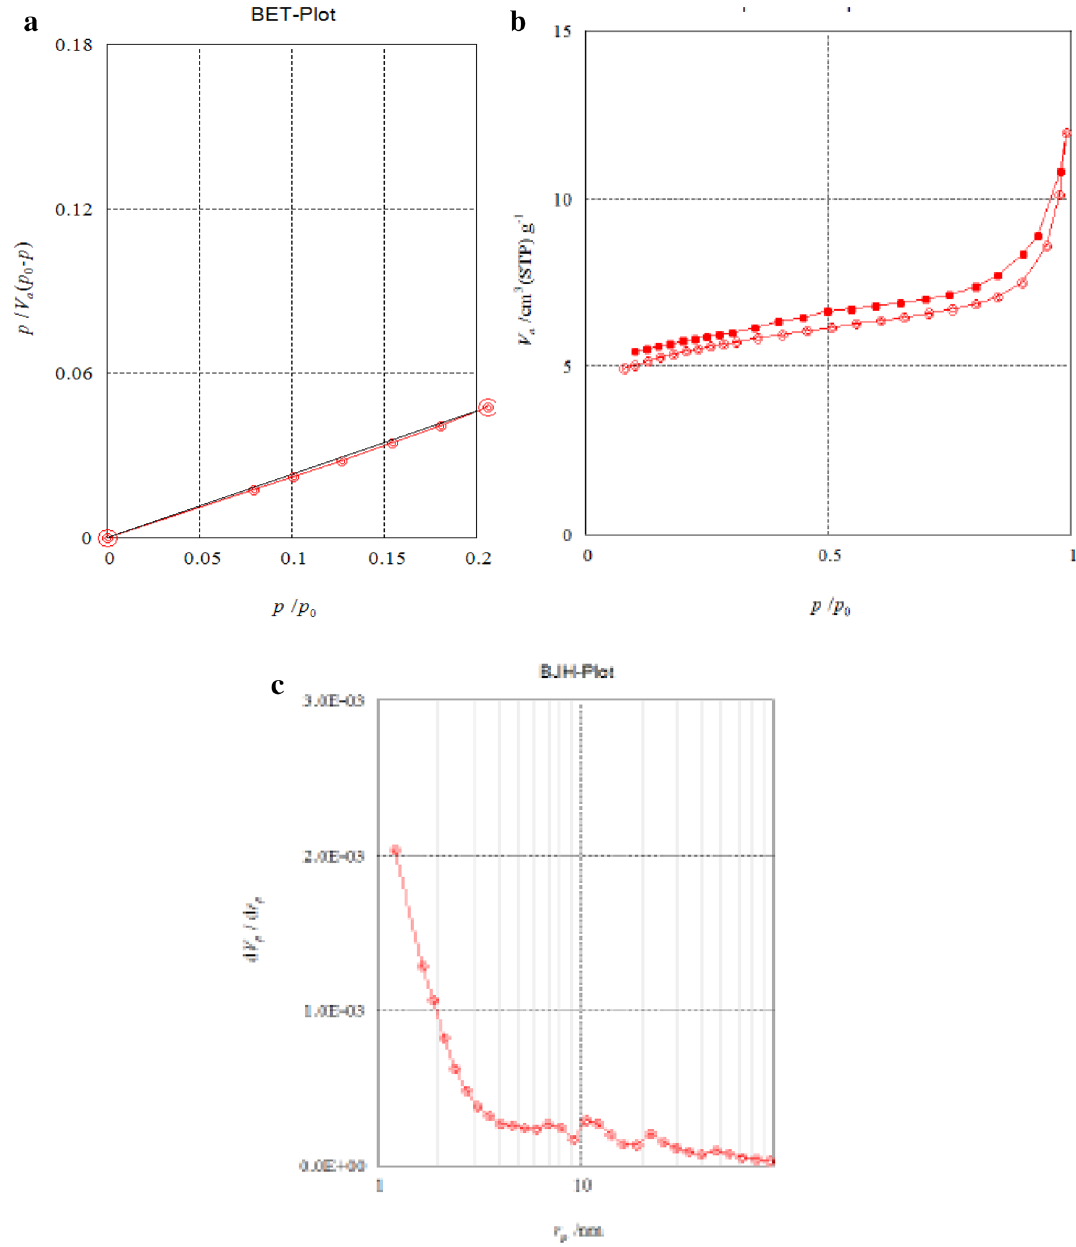
Figure 7. ( a) BET-plot of Zn loaded carbon sphere. ( b ) Adsorption/desorption isotherm of Zn loaded carbon sphere. ( c ) BJH pore size distribution curve of Zn loaded carbon